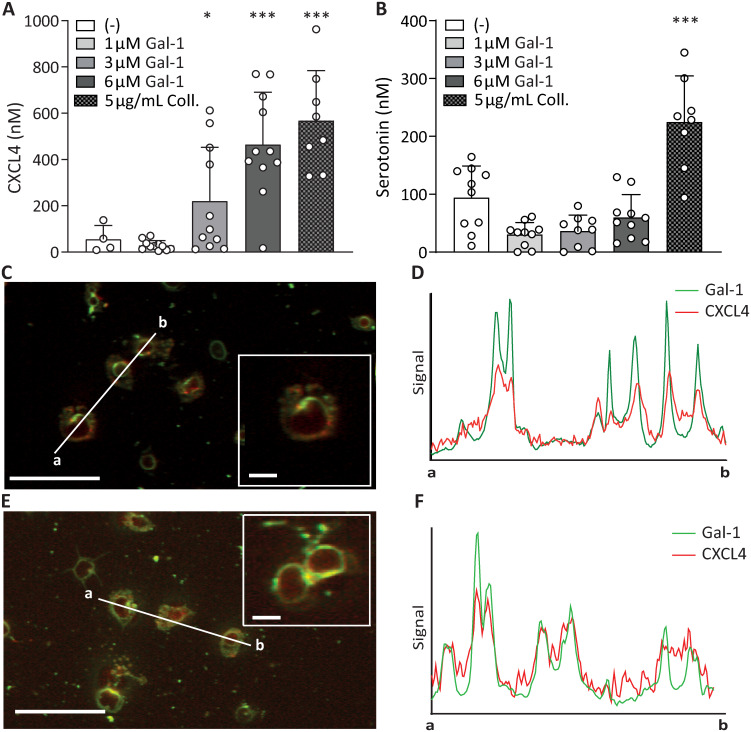
Galectin-1 binds to platelets, co-localizes to CXCL4 and causes CXCL4 release.Absolute levels of CXCL4 (A) and serotonin (B) released from platelets activated with gal-1 (1, 3 or 6 μM), or 5 μg/mL collagen as a control α-granule release agent. (C,E) Confocal microscopy of spread platelets on poly-L-lysine. Platelets were then incubated with OG-gal-1 (green), then fixed and stained with a primary antibody against CXCL4, and AF-647 labeled secondary antibody (red). Inset: enlarged section of image. (D,F) Intensity profile through 3 adjacent platelets, indicated by line a-b in C and E, showing gal-1 levels (green) and CXCL4 levels (red).*p < 0.05, ***p < 0.001 as compared to control (Kruskal Wallis/Dunn’s test). Scale bar: 25 μm, inset: 5 μm.